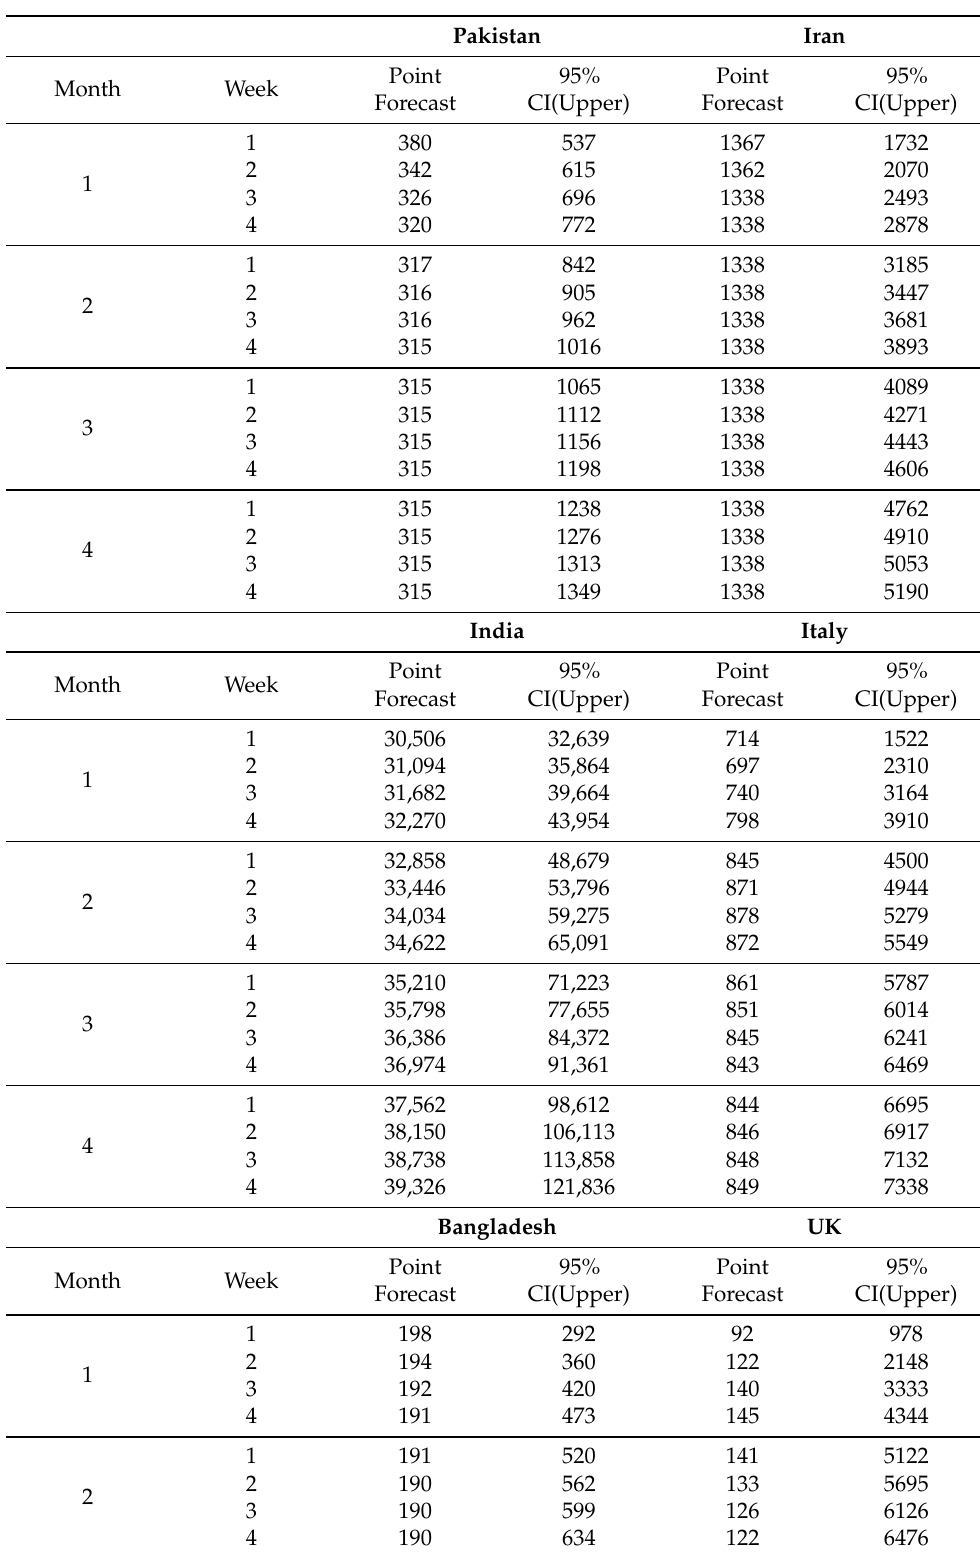
Table 8. Upcoming 16-week forecast for weekly deaths from COVID-19 for Bangladesh, China, Germany, India, Pakistan, Iran, Italy, the United Kingdom, and the world.